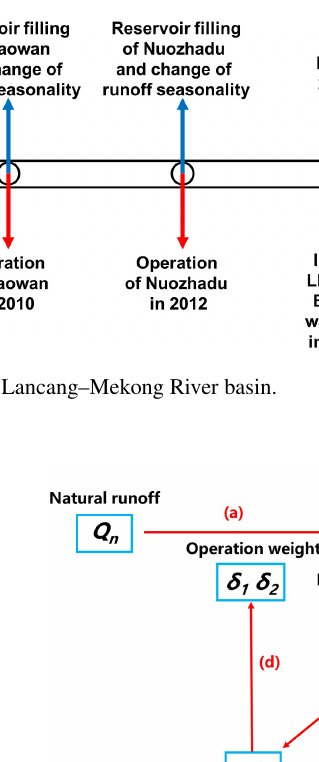
Figure 3. Framework of transboundary river socio-hydrological model. (a) Reservoir operations with regulation rules, constraints and operation weights. (b) Economic benefit calculations in hy- dropower, agriculture and fishery. (c) Cooperation calculations based on economic benefits. (d) Cooperation feedbacks to change operation weights, δ 2 = C